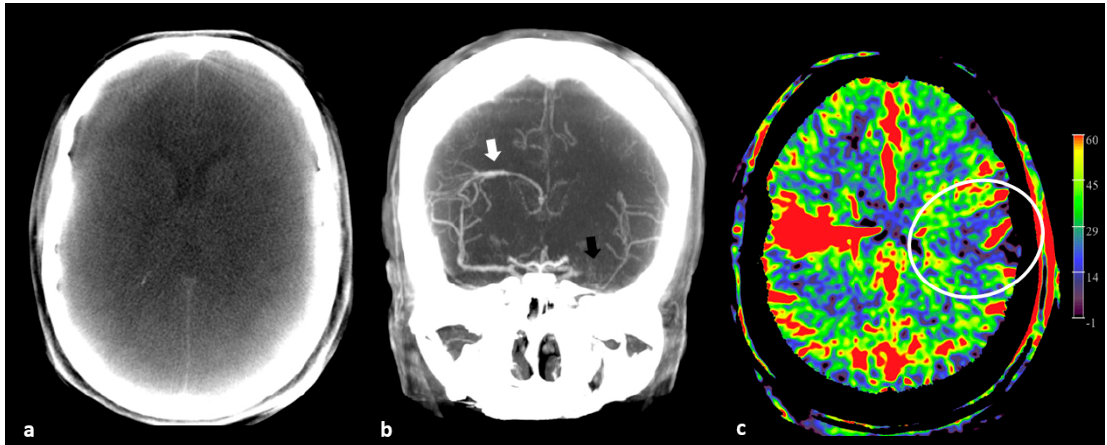
Figure 1. Three available maps by FD PBV imaging. ( a ) Axial maximum intensity projection (MIP) reformation of PBV mask run in an acute ischemic stroke (AIS) patient demonstrates no obvious signs of infarct. However, the image quality is rather low. ( b ) Coronal fill run MIP image in another AIS patient shows no filling of the left middle cerebral artery (MCA, black arrow) M1-segment. Collateral filling post-occlusion is nicely demonstrated. As an incidental finding, a developmental venous anomaly (DVA, white arrow) is noted. ( c ) A PBV axial MIP reformation of the same patient of ( b ) (at the level of the DVA) displays a territorial low PBV area (ellipsoid), corresponding with the perfusion deficit area caused by the MCA M1-segment occlusion.